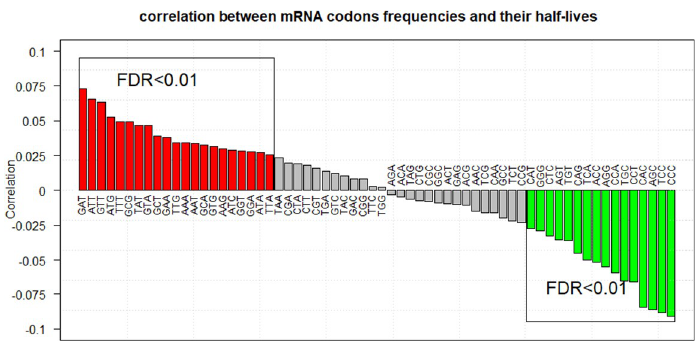
Fig 8. Spearman correlation coefficients between the half-lives of mRNAs and their codon contents are displayed, in which the red bars stand for the positive correlation of the 21 codons with their FDR values less than 1.00E-2 and the green bars stand for the negative correlation of the 16 codons with their FDR values less than